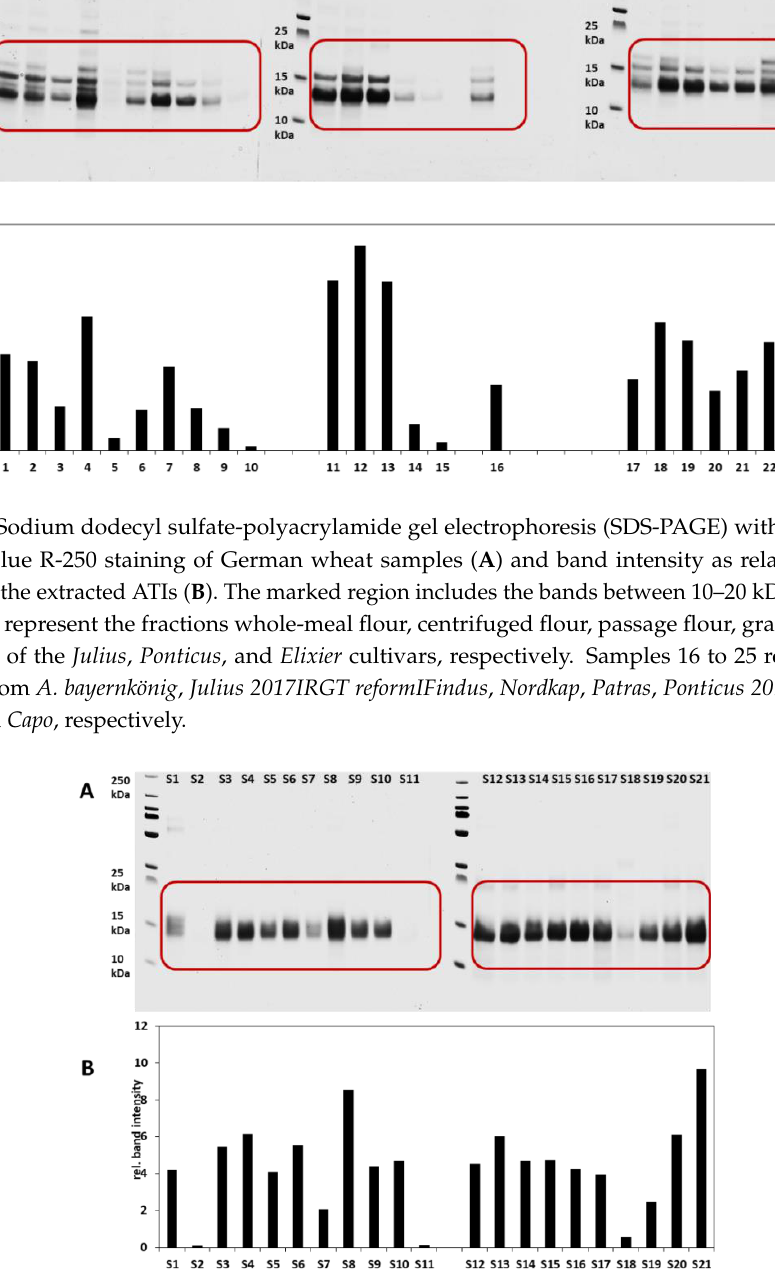
Figure 4. SDS-PAGE with Coomassie Brilliant Blue R-250 staining of Turkish wheat samples ( A ) and band intensity as relative protein content of the extracted ATIs ( B ). S1-S21 represent Kunduru , Siyazan , Tosunbey , Tosunbey , Esperya, Kayra , Sivas 111/33 , Ceyhan-99 , Ceyhan-99 , Pehlivan , Siyazan , Russian , Esperya , Ceyhan-99 , Russian , Pehlivan , Bezostaja , Siyazan , AK-702 , Esperya , and Altay cultivars, respectively.